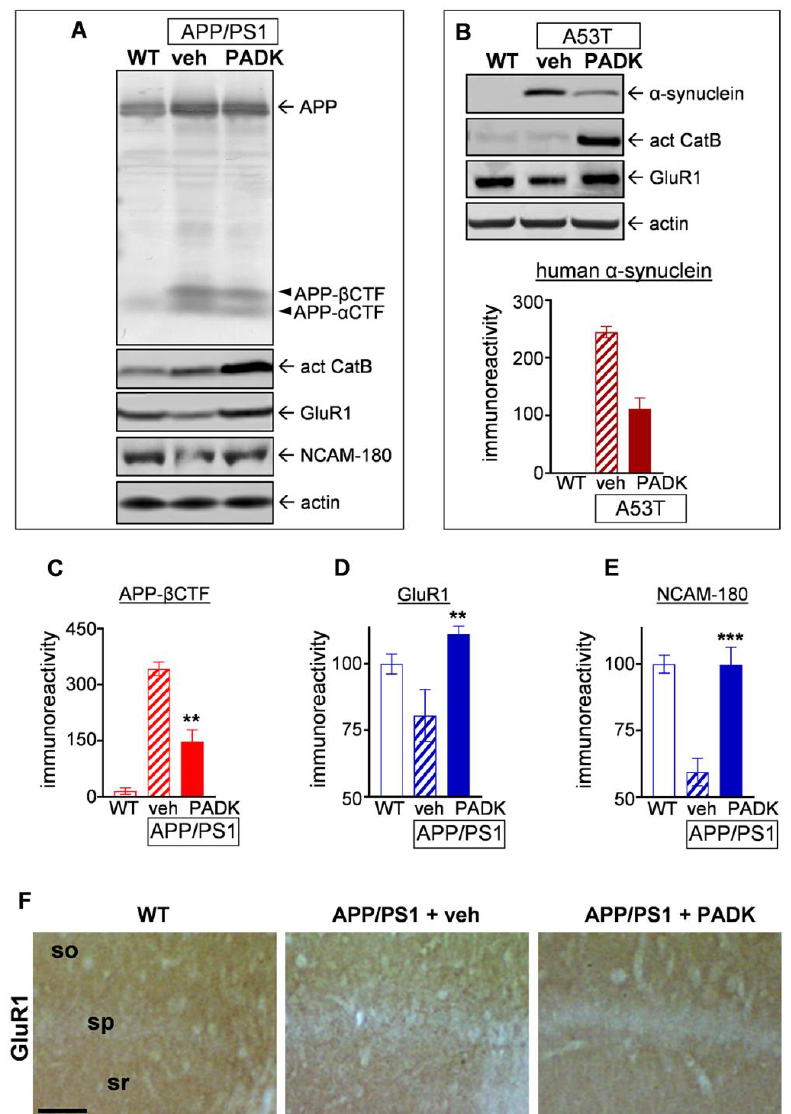
Figure 3. Positive CatB modulator PADK reduces distinct protein accumulation events in association with the recovery of synaptic markers in hippocampus. Equal protein aliquots of brain samples from wild-type mice (WT) and from APP/PS1 mice treated with either vehicle or PADK (18 mg/kg daily for 11 days; intraperitoneally (i.p.)) are shown in cropped immunoblots that were assessed for the α -cleaved and β -secretase-derived carboxyterminal APP fragments (APP- αCTF and APP - βCTF) , active CatB isoform (act CatB), synaptic markers GluR1, neural cell adhesion molecule (NCAM)-180, and actin for a load control ( A ) (see immunoblots in Supplementary Materials). Brain homogenate samples from vehicle- and PADK-treated A53T Parkinson’s disease transgenic mice (18 mg/kg, 11 days; i.p.), in cropped immunoblots, were similarly assessed alongside control samples, to label human α -synuclein, active CatB, GluR1, and actin ( B ) (the immunoblots are also presented in Supplementary Materials), and integrated optical density measures for the labeled α -synuclein band are shown (Kruskal – Wallis test: p < 0.01). To evaluate vehicle- vs. PADK-treated APP/PS1 samples, the immunoreactivity measures for APP- βCTF were plotted ( C ), along with the GluR1 ( D ) and NCAM-180 ( E ) measures normalized to their respective levels in wild-type animals. Unpaired, nonparametric Mann – Whitney tests compared to the vehicle-treated transgenic group: ** p <0.01, *** p < 0.001. The AMPA receptor subunit GluR1 immunostaining was assessed in field CA1 ( F , bar size: 100 µm). so, stratum oriens; sp, stratum pyramidale; sr, stratum radiatum.